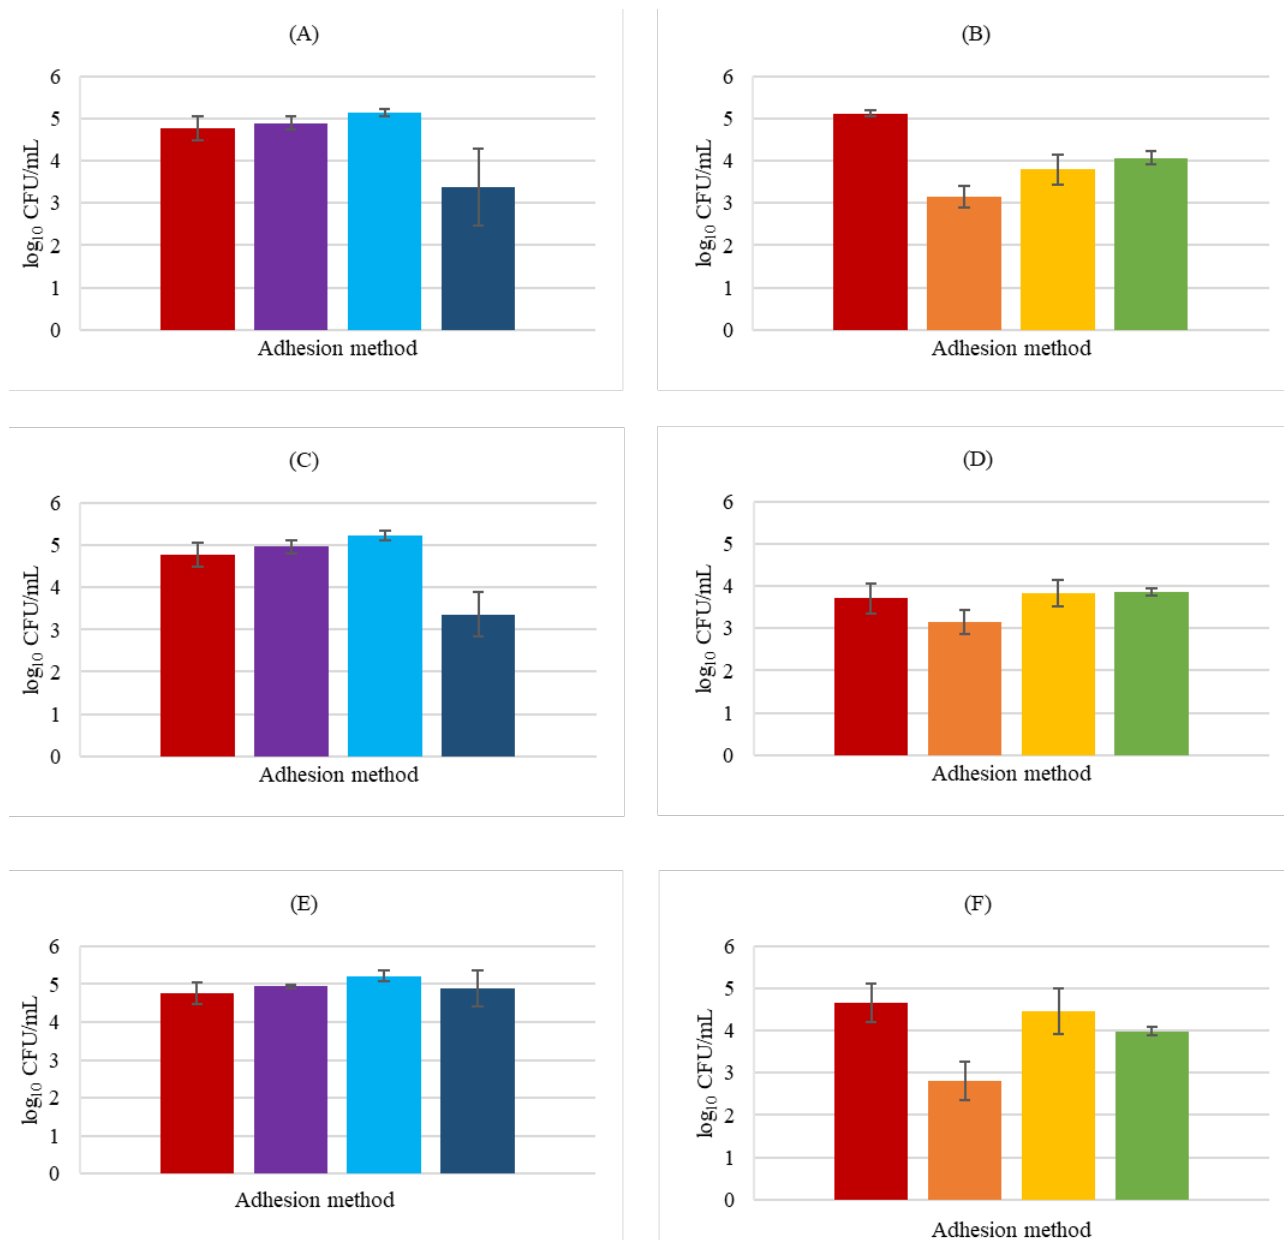
Figure 6. HaCaT cell adhesion by P . aeruginosa in the presence of probiotics. P . aeruginosa plus L . rhamnosus ( A , B ), P . aeruginosa plus L . delbrueckii ( C , D ), and P . aeruginosa plus P. innocua ( E , F ). In BHI medium counts ( A , C , E ) exclusion ( ■ ), displacement ( ■ ), and competition ( ■ ); MRS medium counts ( B , D , F ) exclusion ( ■ ), displacement ( ■ ), and competition ( ■ ); and respective bacterial control ( ■ ). Error bars are ± standard deviation.